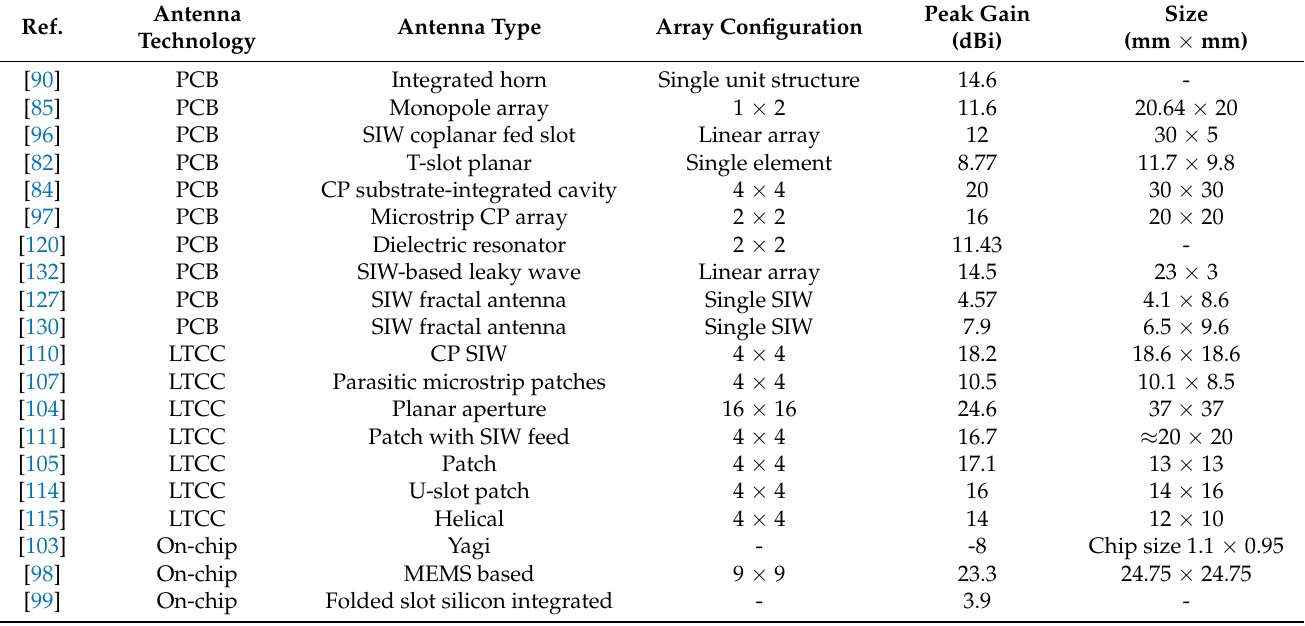
Table 4. Summary of various 60 GHz antenna designs available in the